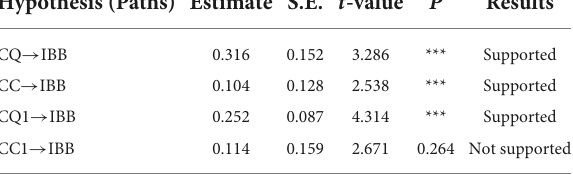
TABLE 6 Model’s path inspection index.